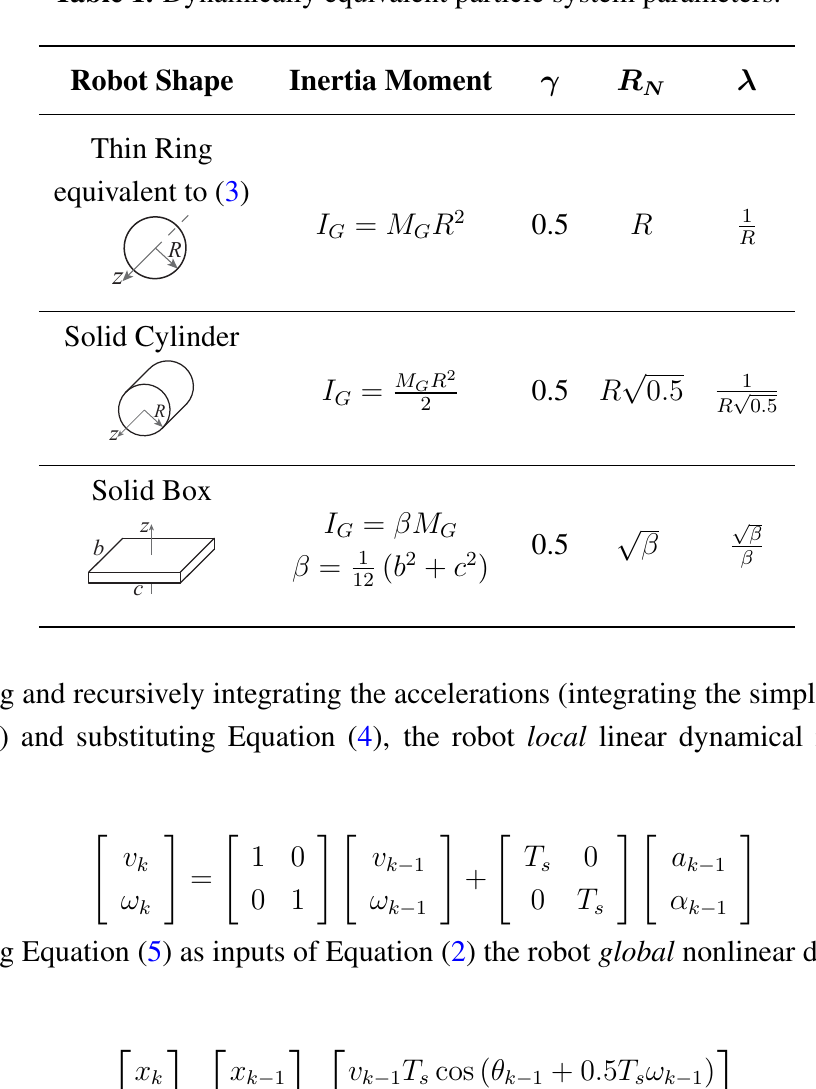
Table 1. Dynamically equivalent particle system